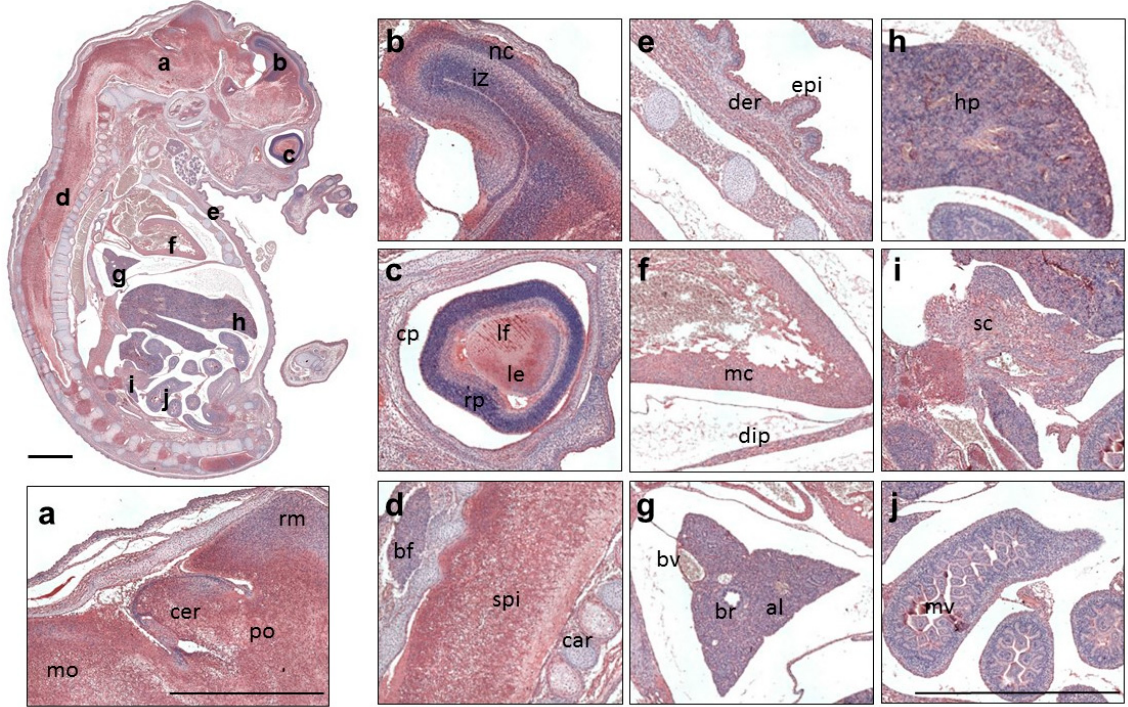
Figure 5. Cellular expression and localization of QSOX1 in tissues of the embryo at 15.5 dpc. The representative longitudinal section of the 15.5 dpc embryo is shown on the top left. The detailed QSOX1 cellular distribution is enlarged from ten subregions (a to f). ( a ) the brain; ( b ) the striatum; ( c ) the eye; ( d ) the spinal cord; ( e ) the skin; ( f ) the heart; ( g ) the lung; ( h ) the liver; ( i ) the pancreas; ( j ) the small intestine. Red colors show QSOX1 staining, and blue shows the counterstain of hematoxylin in the nucleus. Scale bar = 1 mm. Abbreviations: al, alveoli; bf, brown fat; br, bronchus; bv, blood vessel; car, cartilage; cer, cerebellum; cp, corneal epithelium; der, dermis; dip, diaphragm; epi, epidermis; hp, hepatocyte; iz, intermediate zone; le, lens epithelium; lf, lens fiber; mc, myocardial cell; mo, medulla oblongata; mv, mucosal villi; nc, neopallial cortex; po, pons; rm, roof of midbrain; rp, retinal pigment; sc, secretory cell; spi, spinal cord.